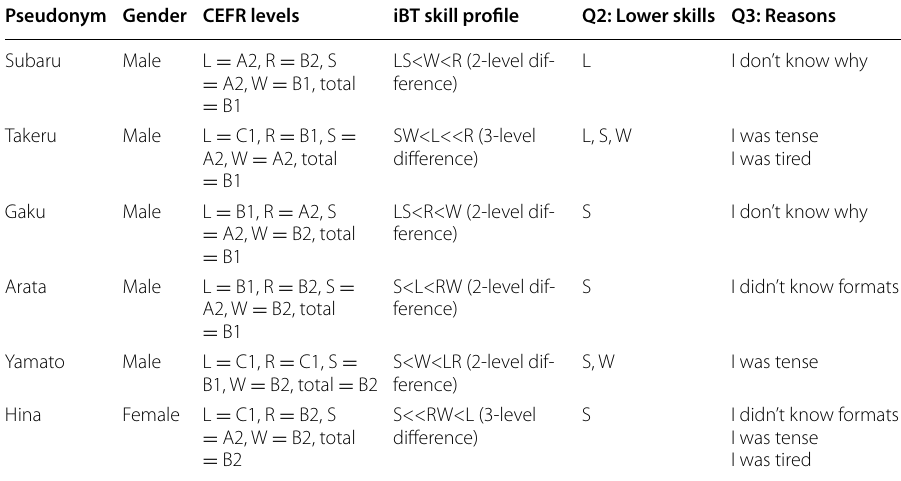
Table 11 Six participants’ characteristics in Study